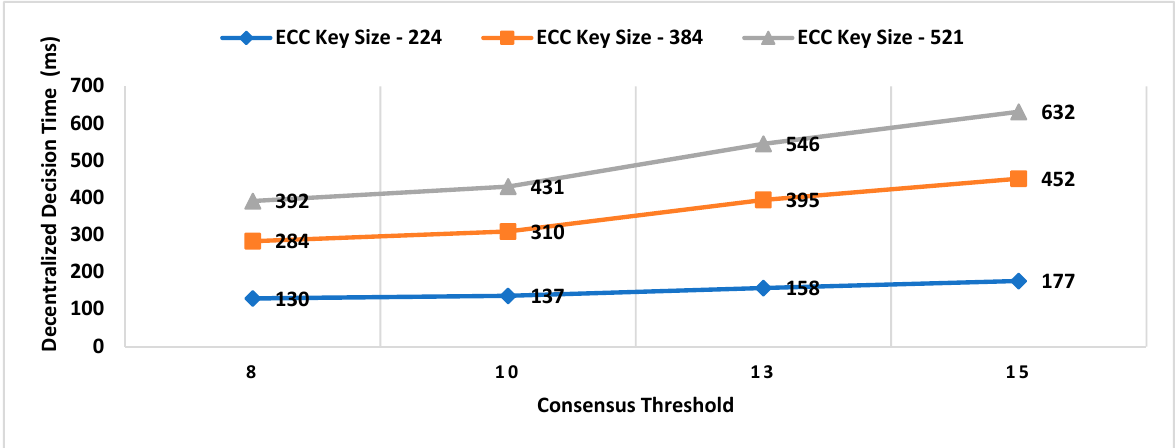
Figure 7. Consensus threshold and key size impact on decentralized decision time.